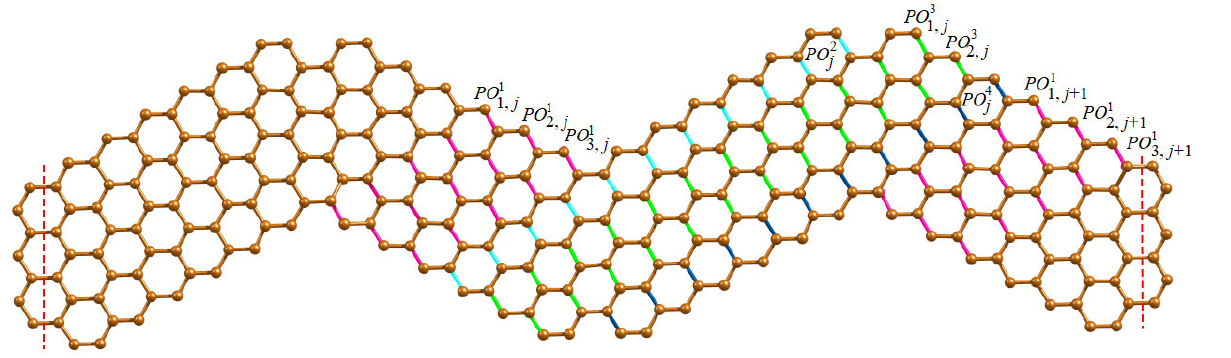
Figure 4. O-type parallelogram Θ -classes on two consecutive units of WNR ( 4,6, n )